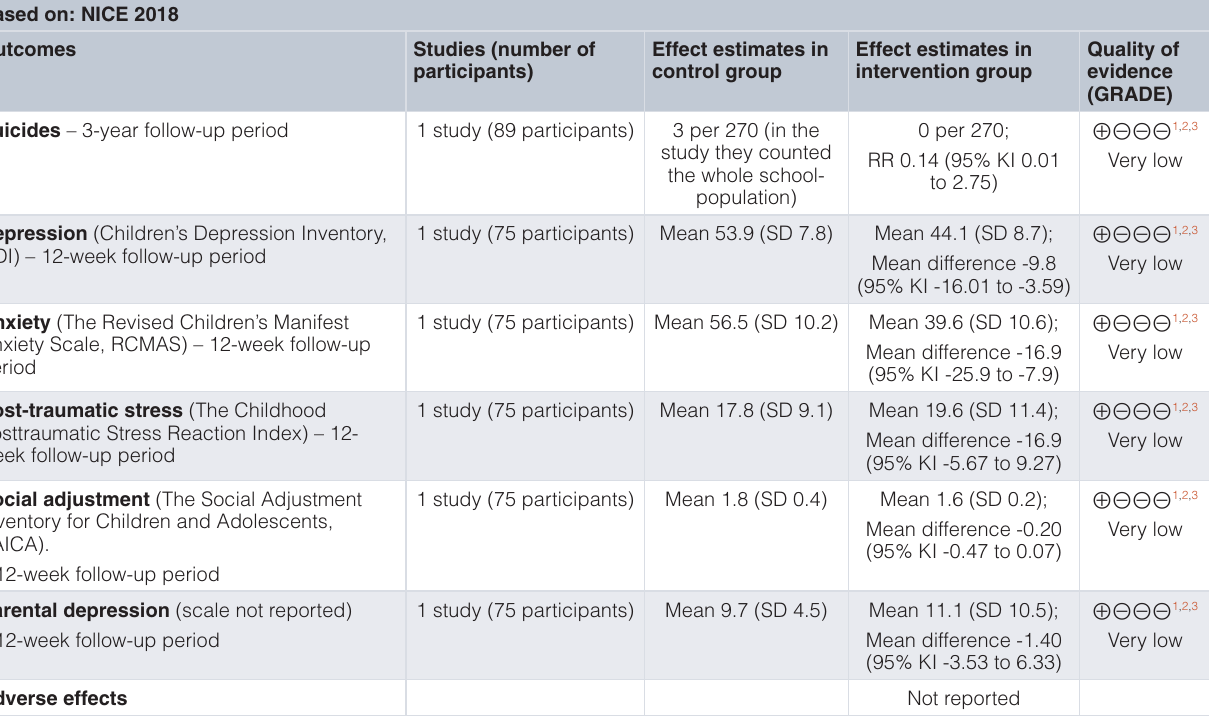
Table 5. GRADE-assessment: Secondary prevention: interventions to support children and adolescents bereaved or affected by a suspected suicide versus treatment as usual (TAU) or historical control. Population: Children and adolescents in primary and secondary school (under the age of 17) that have lost a friend or parent to suspected suicide Intervention: Interventions to support children and adolescents bereaved or affected by a suspected suicide Control: TAU or historical